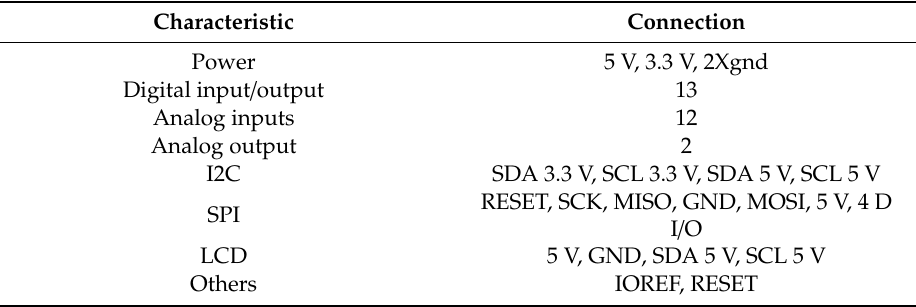
Table 2. LC-DAQ external